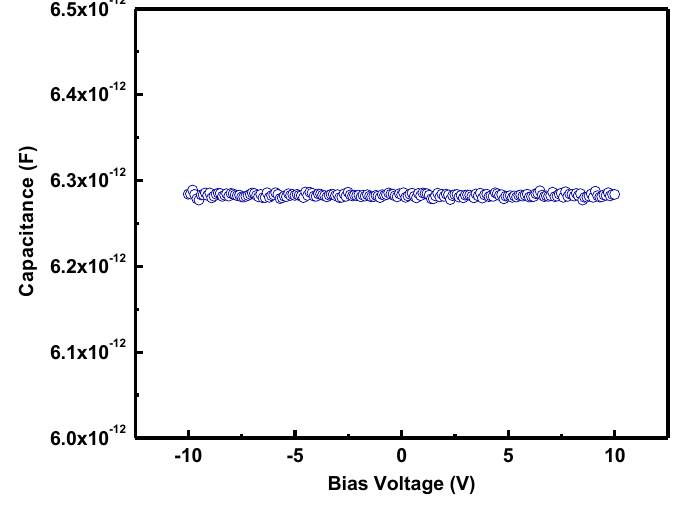
Figure 7. Capacitance (permittivity)-voltage linearity of the Pt/LaGdO metal (MIM) structure at 1 MHz. Reprinted with permission from [15]. Copyright 2012 AIP Publishing